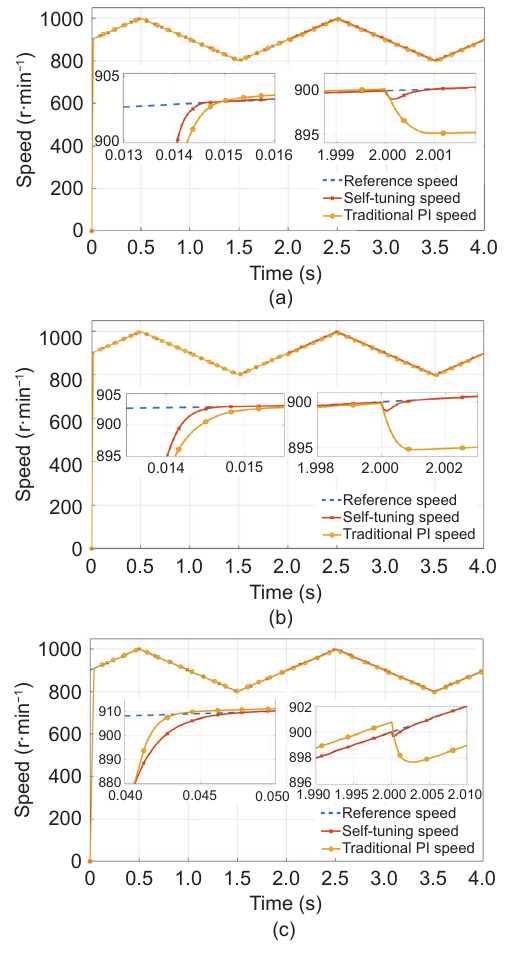
Fig. 16 Speed waveforms. (a) B =0.004 N·m·s·rad −1 , J = 0.003 kg·m 2 . (b) B =0.004 N·m·s·rad −1 , J =0.009 kg·m 2 . (c) B =0.008 N·m·s·rad −1 , J =0.009 kg·m 2 .